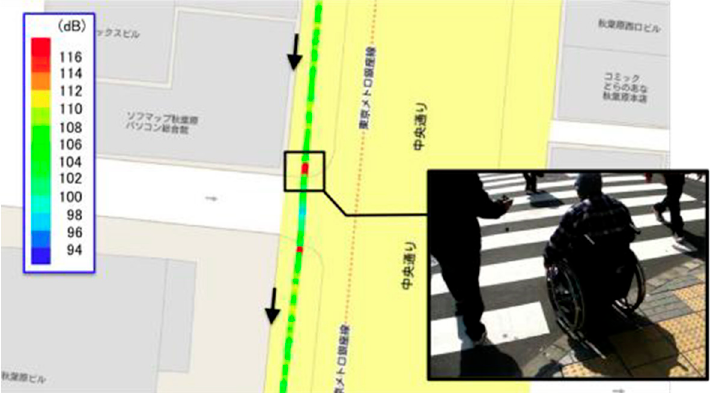
Figure 2. A 50 years old male participant with a rheumatoid and paralyzed arm moves his manual wheelchair. Although he tried to control his wheelchair carefully throughout this experiment, higher VAL values were detected at uneven road surfaces.